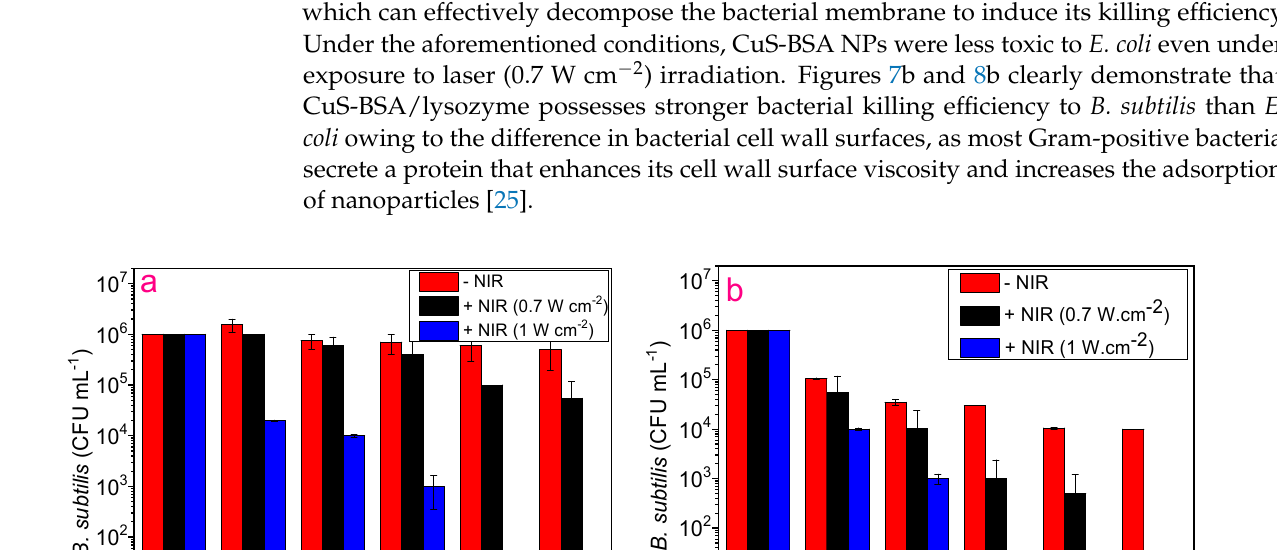
Figure 7. Antibacterial activity of ( a ) CuS-BSA and ( b ) CuS-BSA/lysozyme on B. subtilis using various concentrations with and without NIR irradiation (980 nm, 3 min).